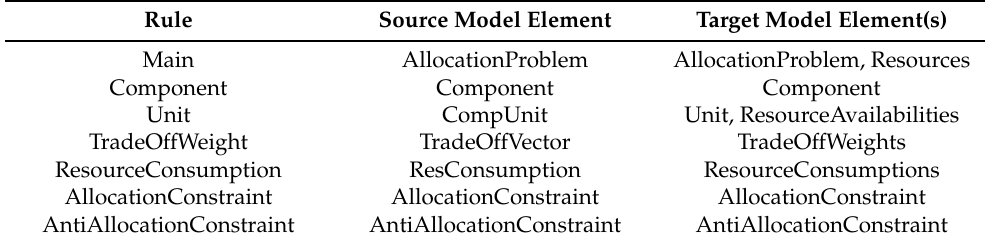
Table 2. Mapping Implemented by the ATL Program in Appendix